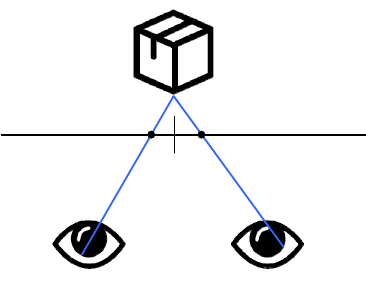
Figure 7. Simple stereo vision model.